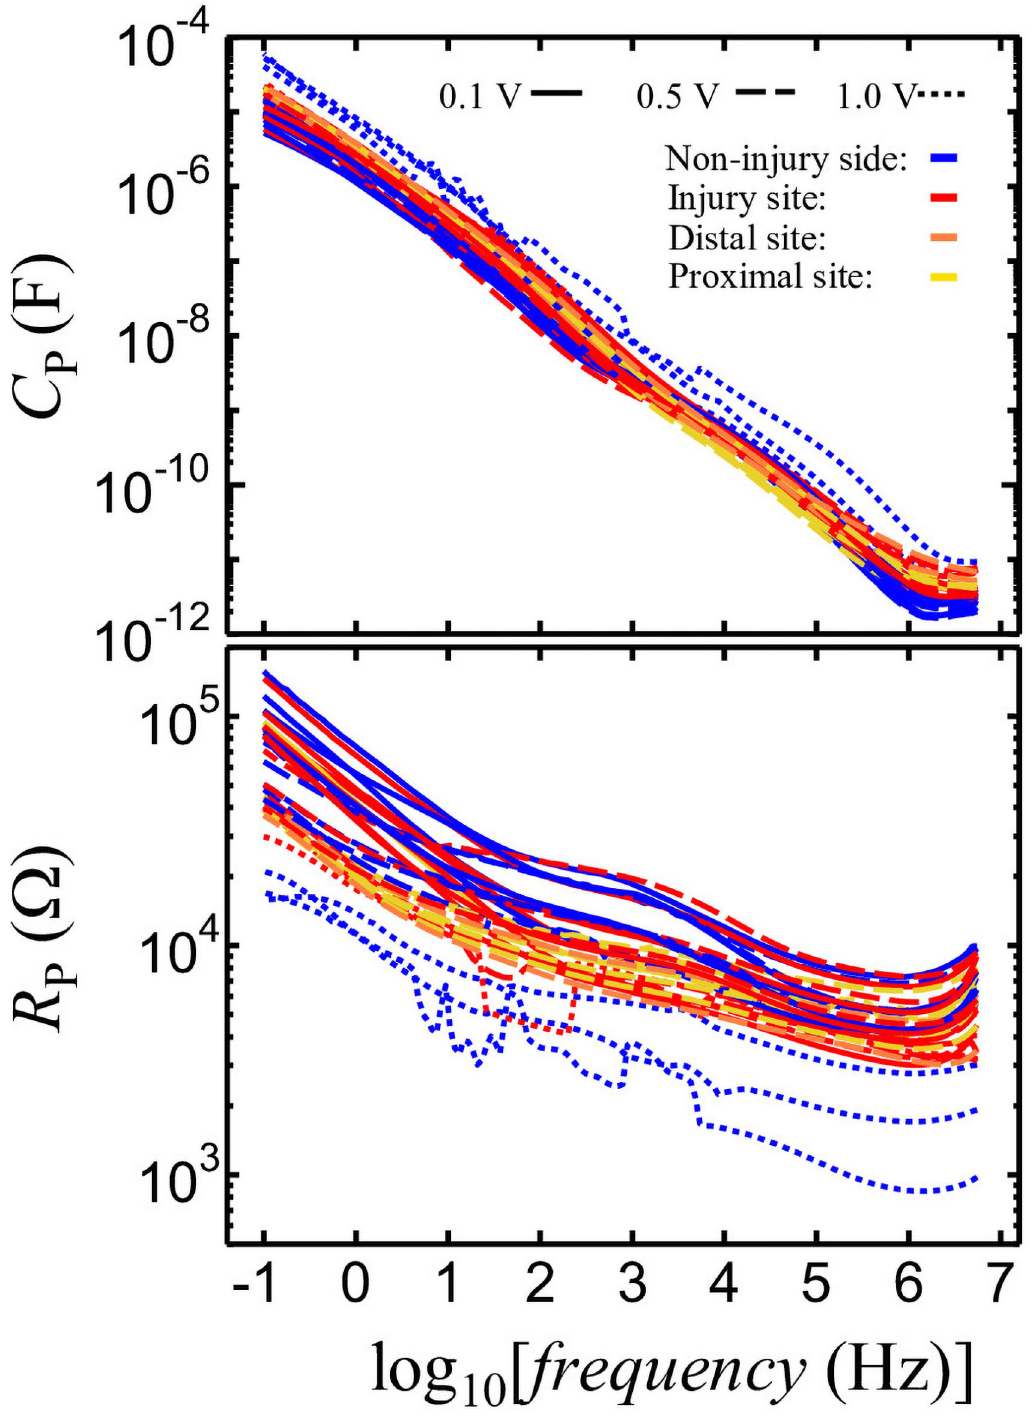
Fig 3. Frequency dependence of nerve Cp and Rp